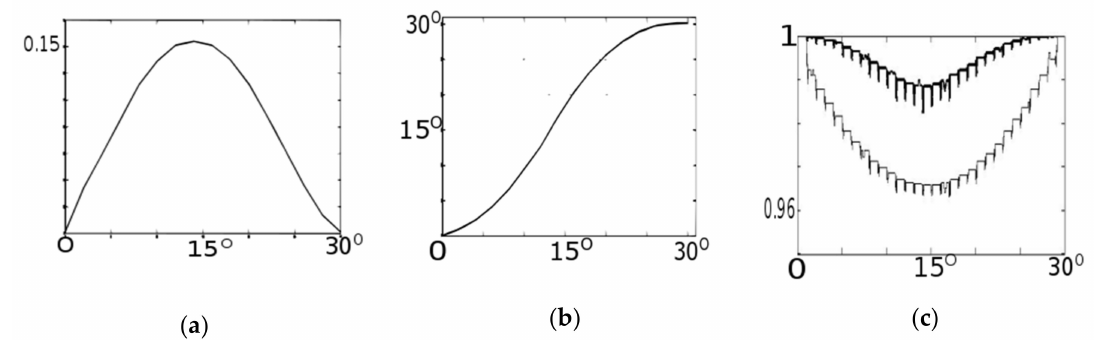
Figure 12. Example of characteristics for 12 × 12 MMCs: ( a ) total harmonic distortion (THD) as a function of a phase shift for the “as close as possible” approach; ( b ) output-voltage phase shift as a function of trajectory shift along the X axis for the “as close as possible” approach; ( c ) voltage transfer as a function of the input–output phase shift and the “as close as possible” control